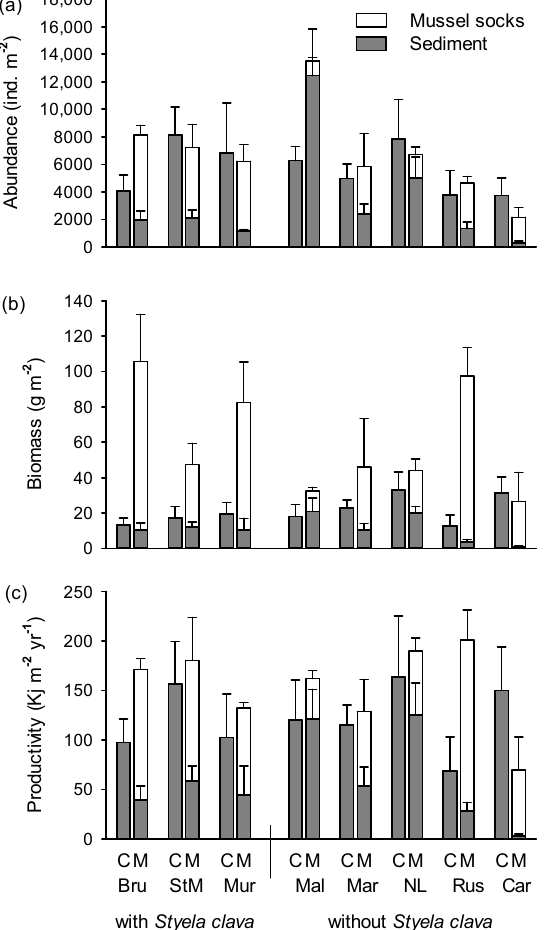
Figure 2. Mean (±SE) total (a) abundance, (b) biomass, and (c) productivity of sediment and mussel sock macroinvertebrates in control sites (C) and mussel leases (M) in 3 bays with Styela clava and 5 bays without S. clava (see Figure 1 for bay abbreviations). n = 5 for sediment samples except Mur where n = 4; n = 3 for mussel sock samples except NL and Mal where n = 5. Table 3. Results of ANOVAs to evaluate fixed effects. ( a ) Bay type (with vs. without Styela clava ) and Position (inside vs. outside mussel leases) on log (x + 1)-transformed sediment macroinverte- brate abundance, biomass, productivity, and taxonomic richness, and ( b ) Bay type on log-trans- formed mussel sock macroinvertebrate abundance, biomass, and productivity. Statistically signifi- cant effects are indicated in bold.